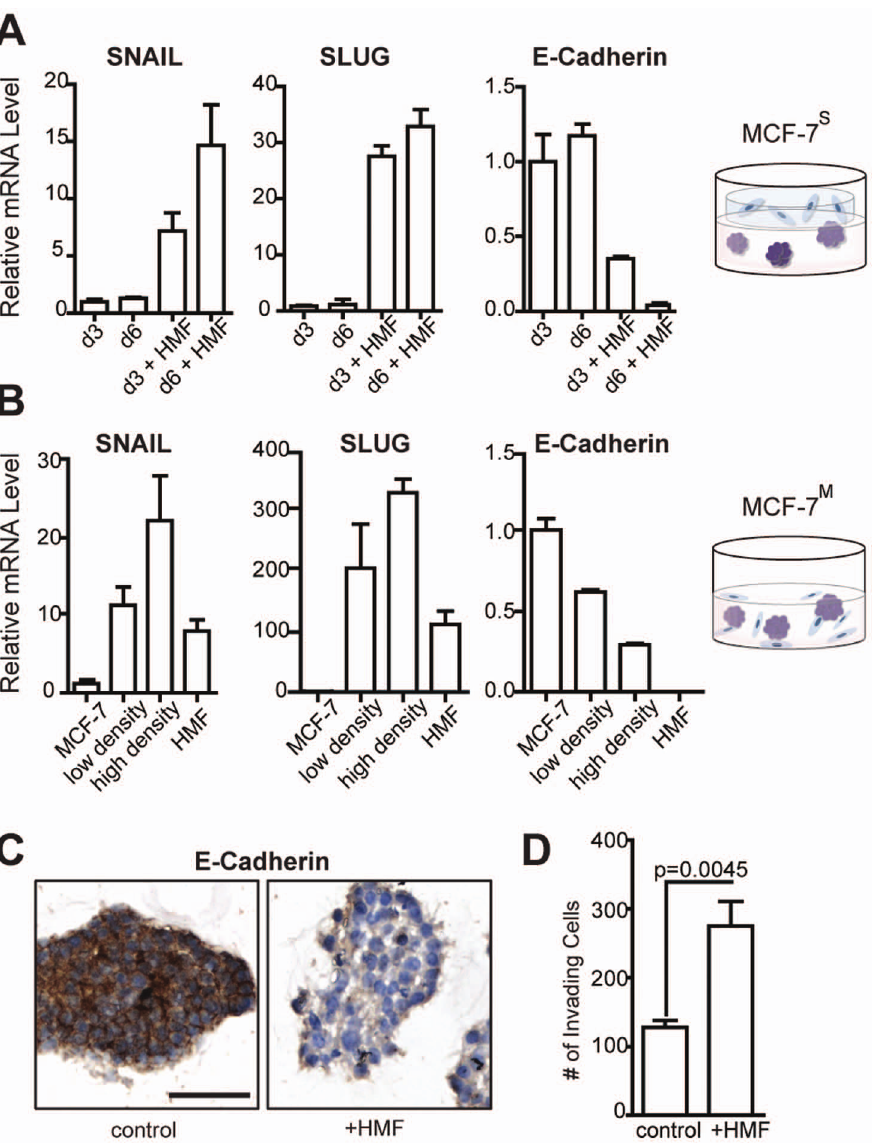
Figure 2. Mammary fibroblasts induce an epithelial-to-mesenchymal transition in ER + breast cancer cells in 3D culture. (A) Over the course of 6 days in the sandwich co-culture, MCF-7 S display increased mRNA levels of EMT markers SNAIL and SLUG with a decrease in E-cadherin mRNA. (B) Mixed co-cultures were prepared at two fibroblast seeding densities, low- and high-density (relative to MCF-7) and EMT markers were modulated up or down as seen with the sandwich co-culture, and a dose-dependent response to the fibroblast presence was observed.